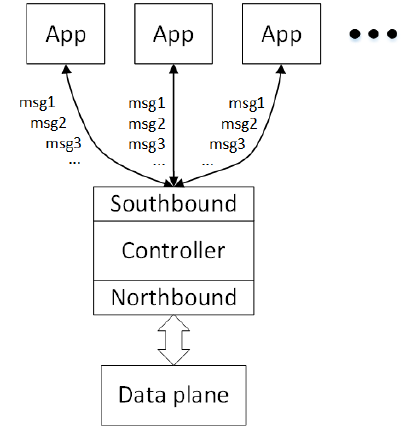
Figure 1. The Common SDN